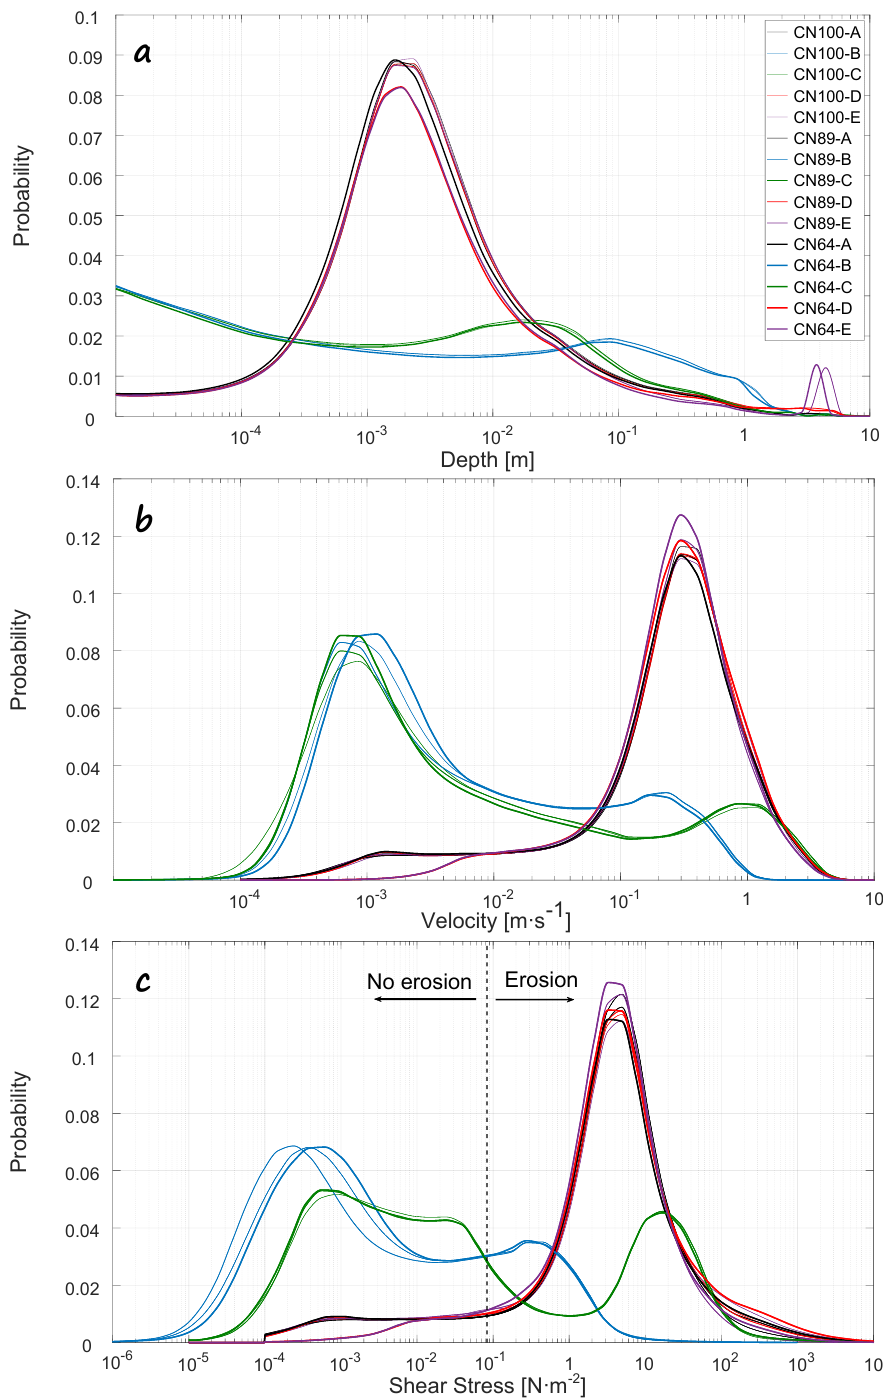
Figure 10. Histograms of the simulated ( a ) flow depth h , ( b ) magnitude of the velocity vector | u | , and ( c ) the skin friction τ bs for the fifteen scenarios explained in Section 3.3.